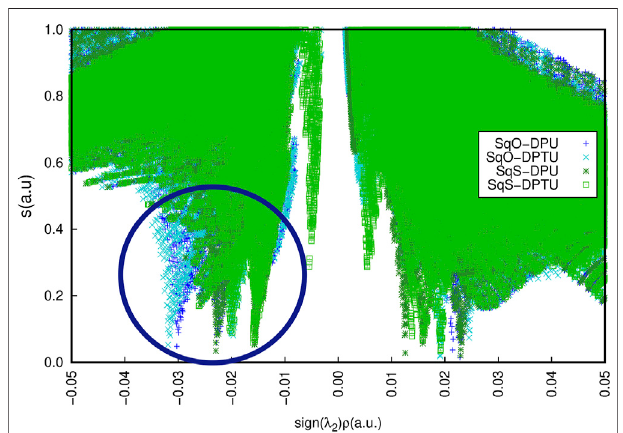
FIGURE 9 | Non-covalent interactions for the unsubstituted systems according to the NCIPlot analysis for OSQ-DPU (blue), OSQ-DPTU (turquoise), SSQ-DPU (dark green), and SSQ-DPTU (light green).